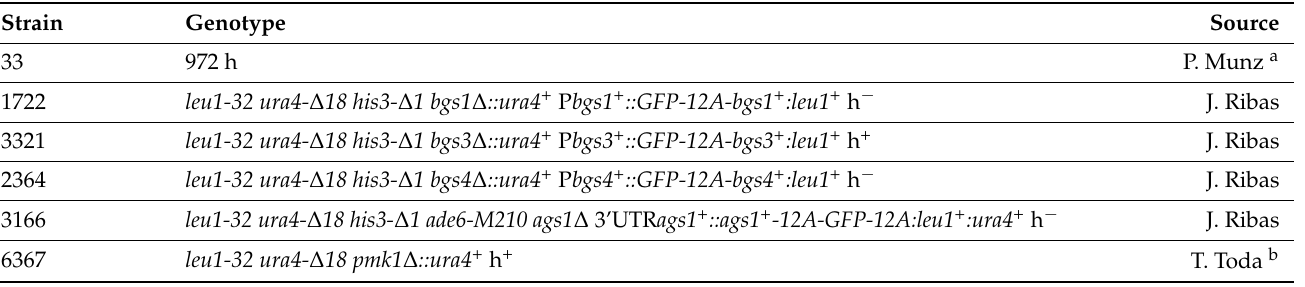
Table 2. Fission yeast strains used in this